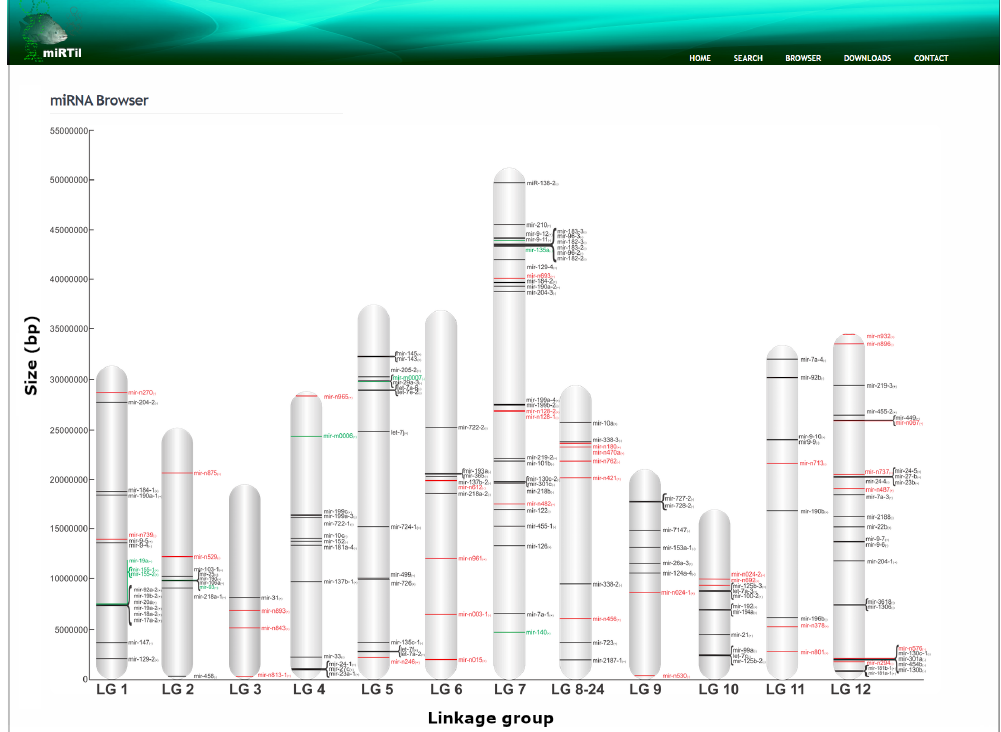
Figure 5. Genomic map of Nile tilapia miRNAs. Red symbols represent novel miRNAs; grey symbols represents conserved miRBase miRNAs [35]; green symbols represent miRNAs identified by other research groups in Nile tilapia. The x-axis shows linkage groups (LGs) from the Nile tilapia assembly (oreNil2), and the y-axis shows the size of LGs (base pair). All miRNAs represented in a single locus or cluster are linkable to detailed miRNA